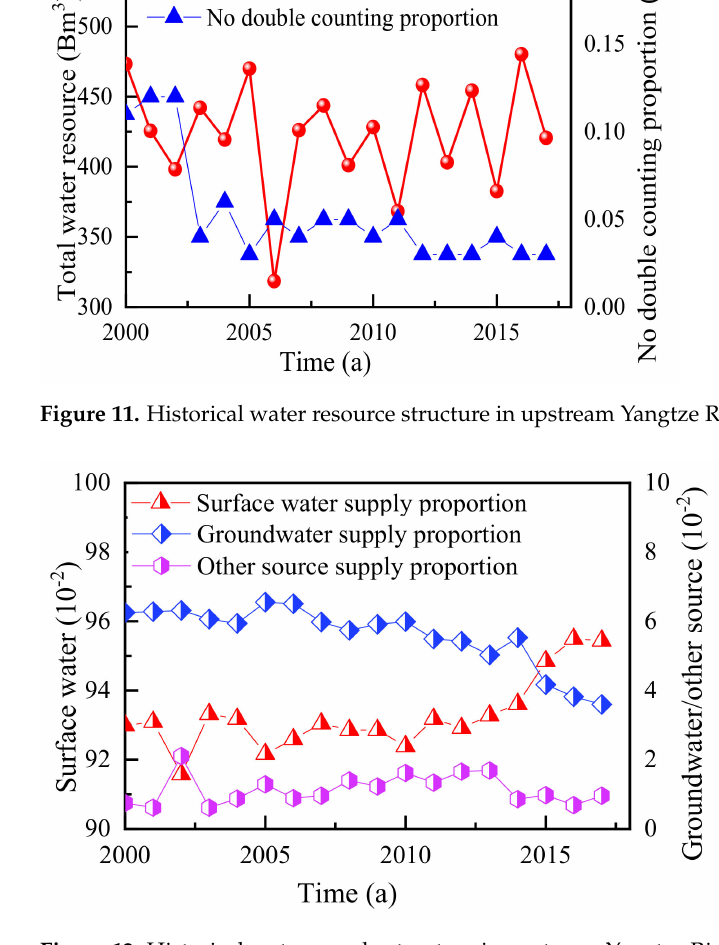
Figure 12. Historical water supply structure in upstream Yangtze